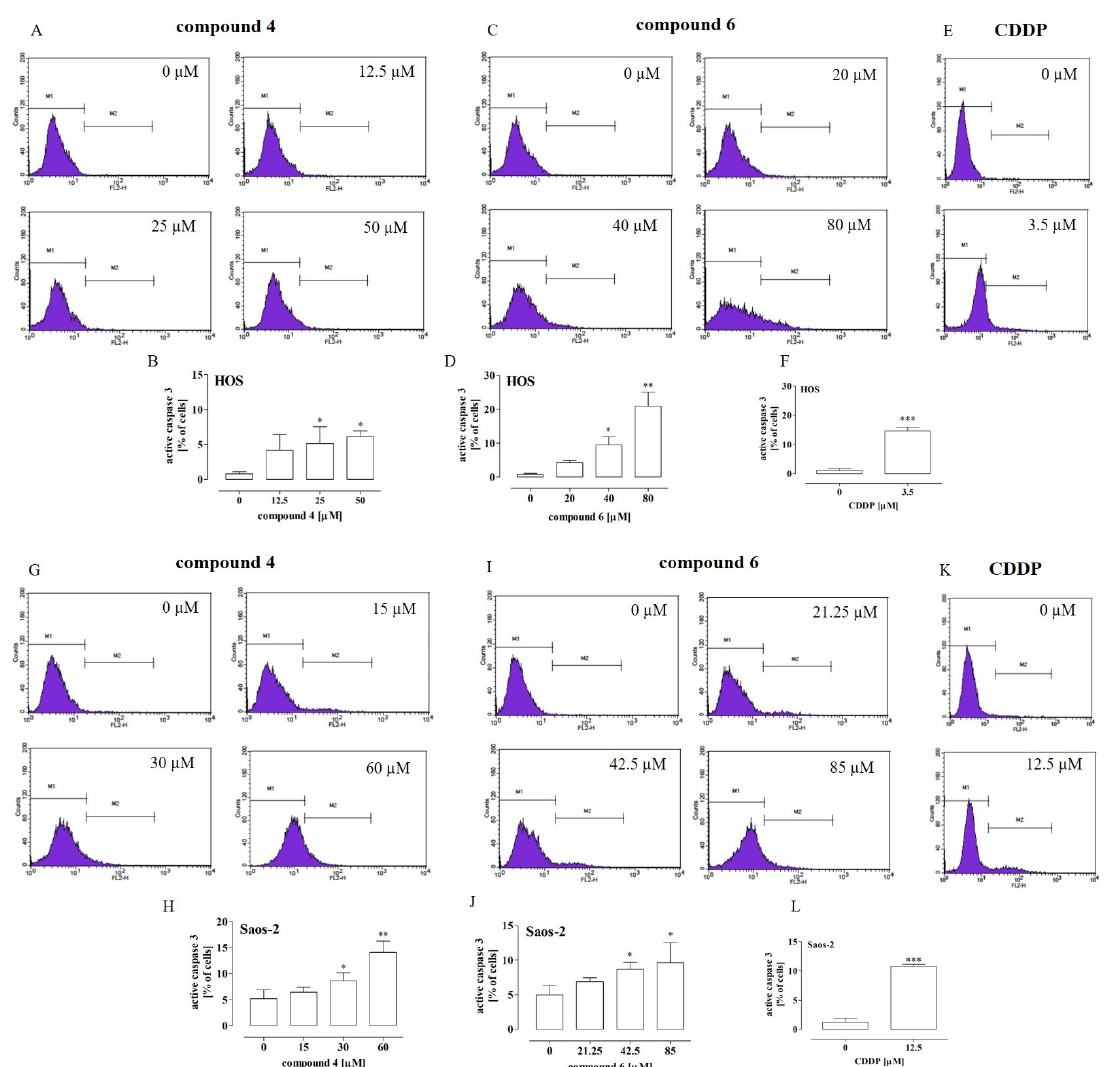
Figure 3. Effect of compounds 4 and 6 and cisplatin (CDDP) on caspase 3 activation in HOS and Saos-2 cells. The cells were treated with the compounds at the indicated concentrations for 72 h. The histograms are representative (HOS—( A , C , E ); Saos-2—( G , I , K )) and correspond with the percentage of cells with active caspase 3 (M2 gate) detected by flow cytometry after cell staining with PE- conjugated anti-active caspase 3 antibodies (HOS—( B , D , F ); Saos-2—( H , J , L )). The results are mean values ± SD of at least three independent experiments. Statistically significant differences: *—at p < 0.05; **—at p < 0.01 or ***—at p < 0.001 in comparison with the untreated cells (one-way ANOVA followed by Dunnett’s post-hoc test or an unpaired